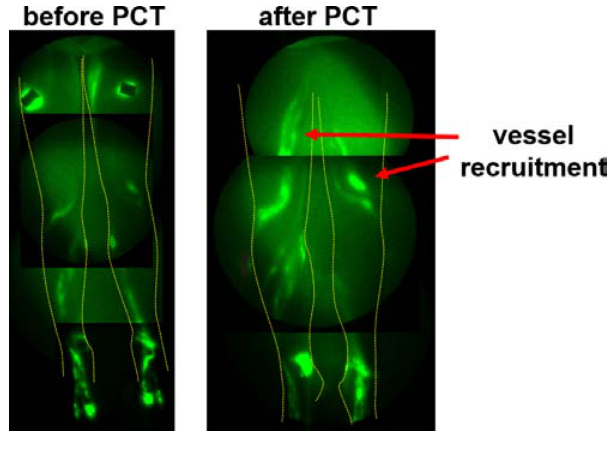
Fig. 9. Subject 3's anterior NIRFLI images before and after PCT.